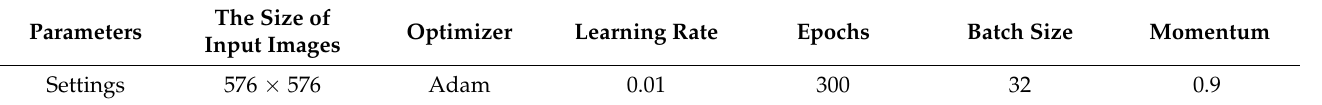
Table 2. Configuration of training parameter value for Comparison Experiment.